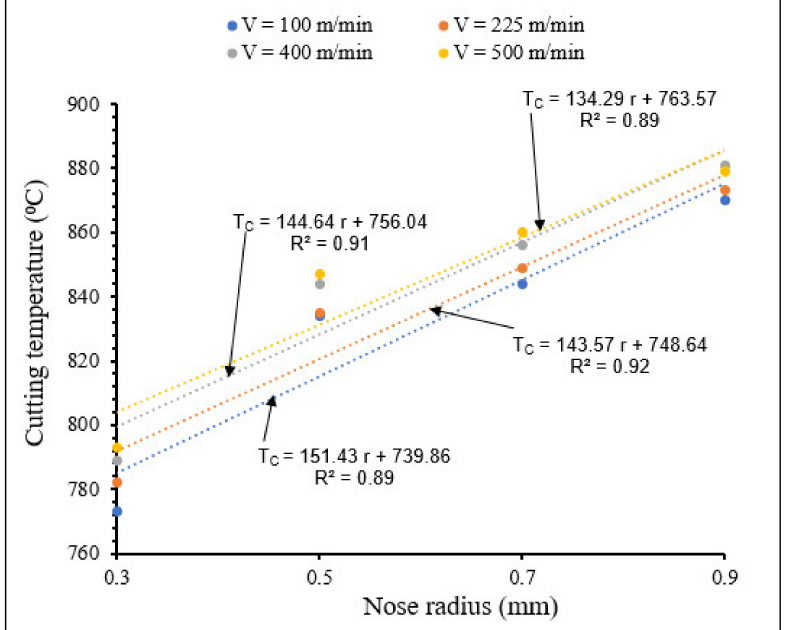
Figure 17. Variation of maximum temperature with large nose radius for different cutting speeds at f = 0.1 mm/rev, γ = 5 ◦